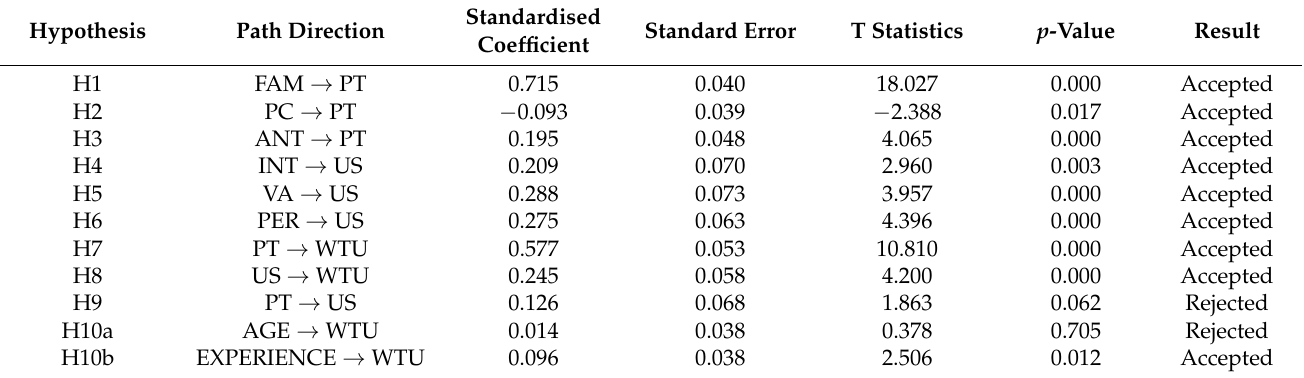
Table 6. The results of path